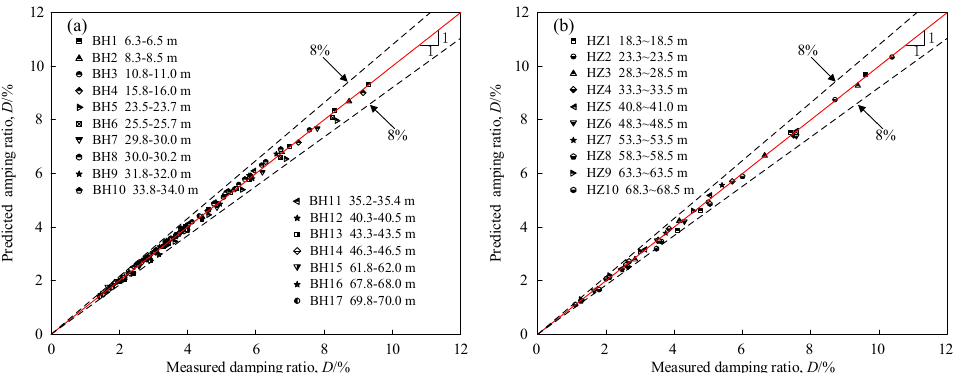
Figure 9. Comparison of predicted and measured values of the damping ratio D of marine clays from ( a ) Bohai Bay; ( b ) Hangzhou Bay.